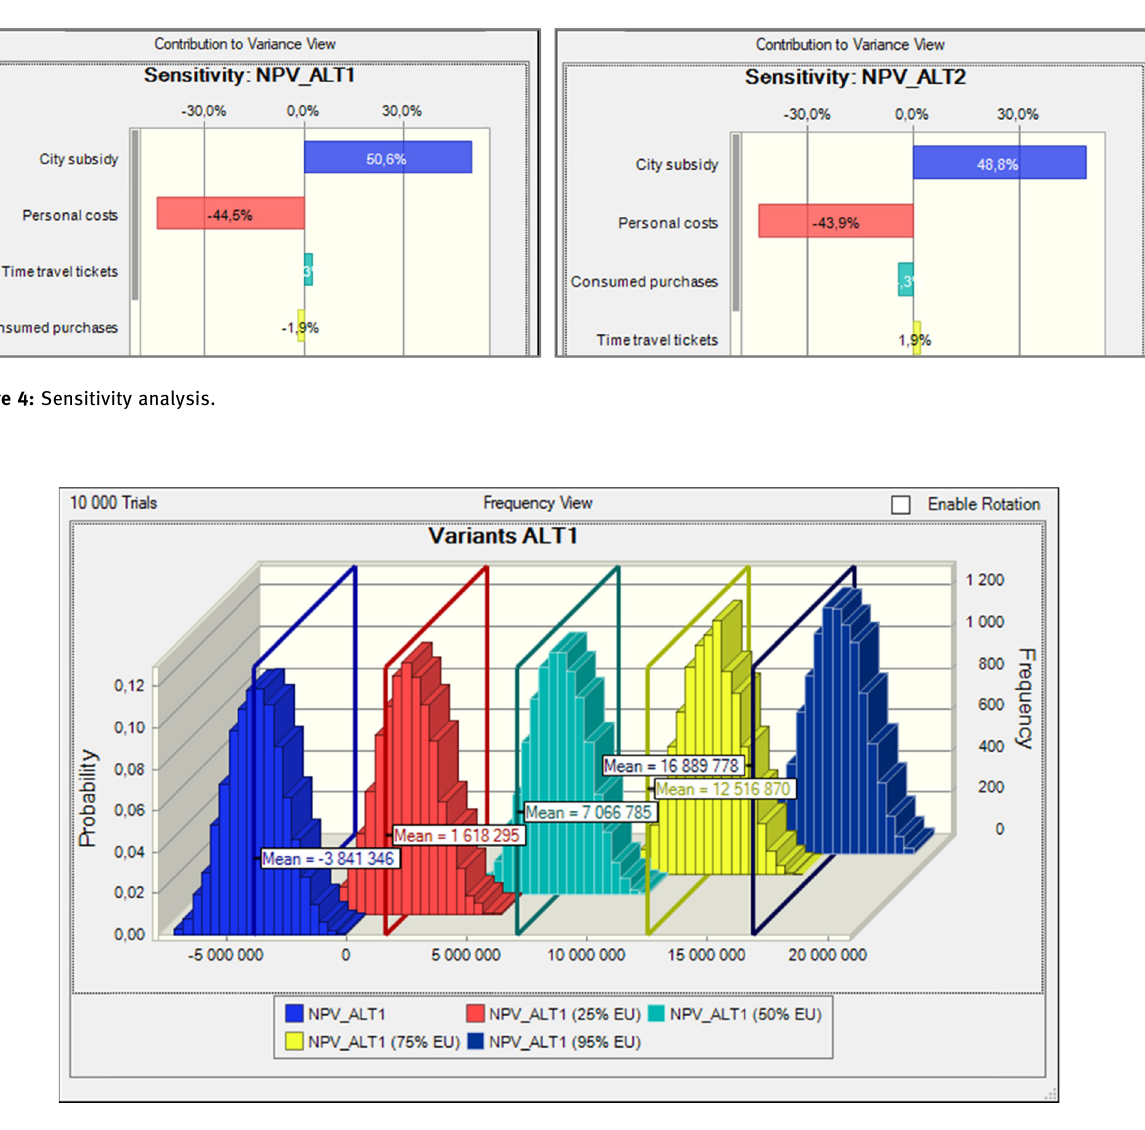
Figure 5: NPV_ALT1 at di ff erent levels of investment fi nancing support.